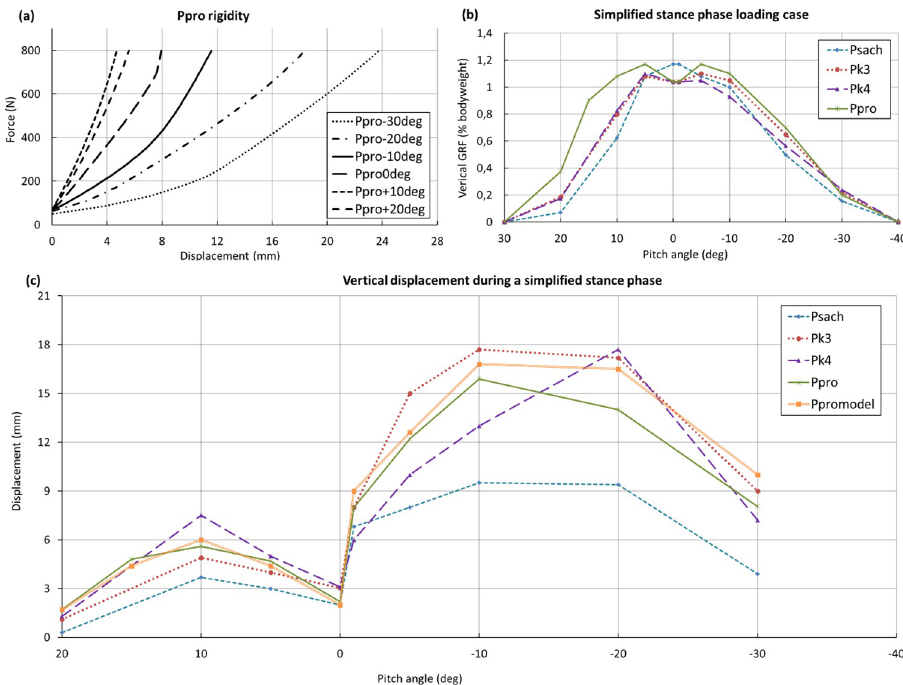
Fig 8. Evaluation of the load-deflection response. (a) Representation of the P PRO rigidity at different angles. (b) Simplified loading representation of the NvGRF. (c) Representation of the vertical deformation of different feet during a stance phase. Please note that Pk3 denotes the P K3_C foot